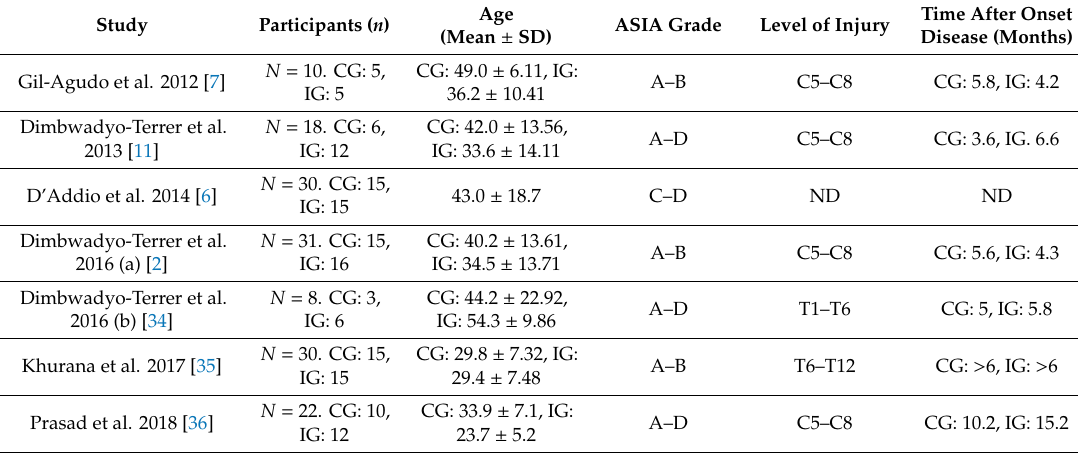
Table 2. Main characteristics of the participants in each